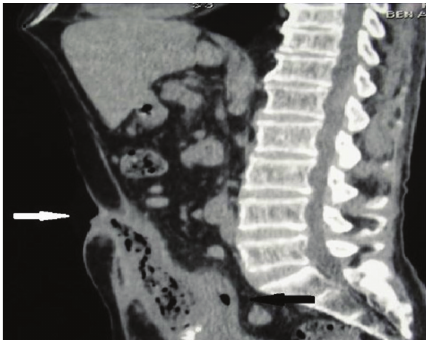
Figure 2: CT reconstruction image revealed a colo-urachal- cutaneous fistula (urachal-cutaneous fistula, white arrow), (colo- urachal communication, black arrow).